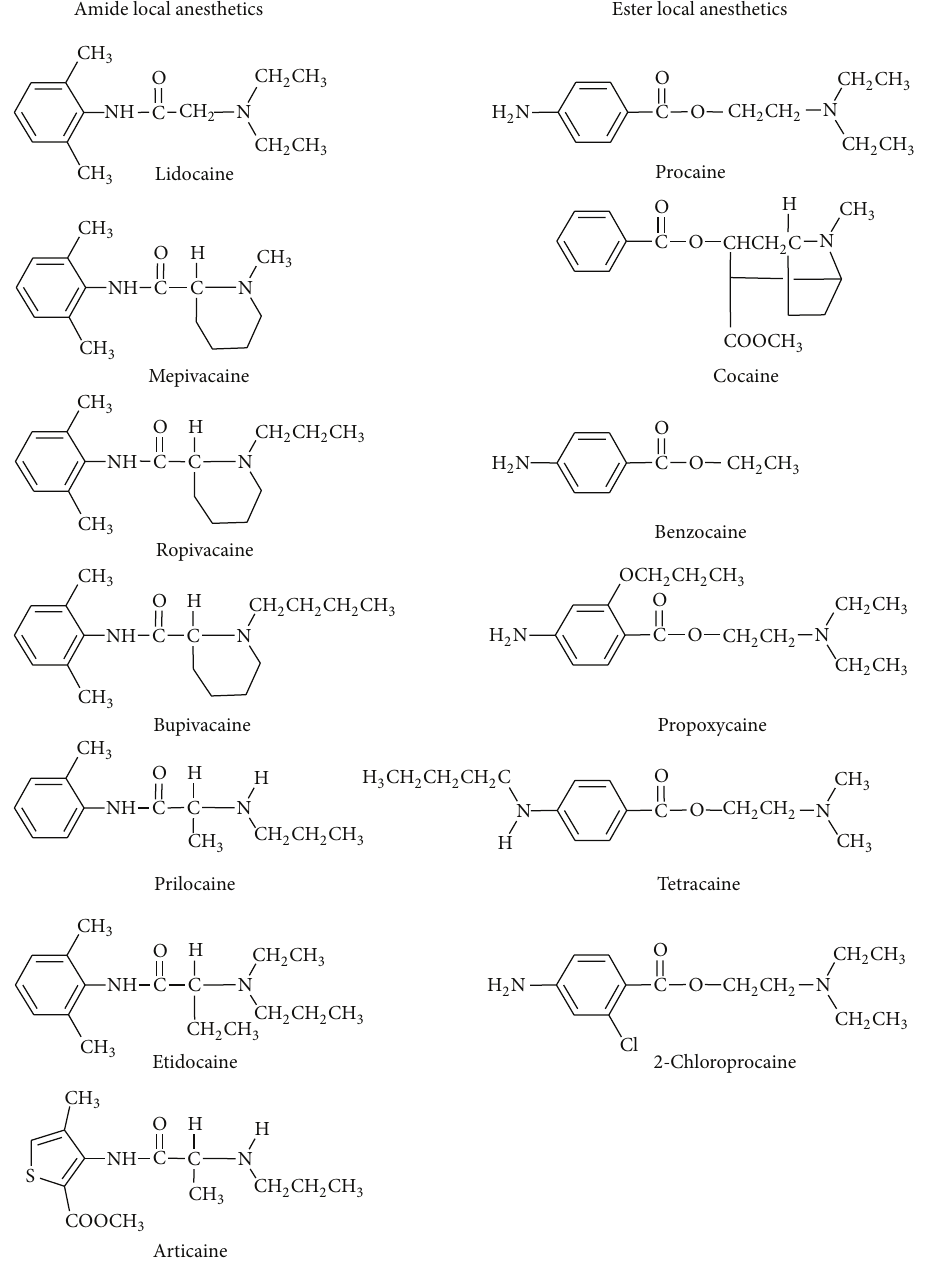
Figure 1: Representative amide and ester local